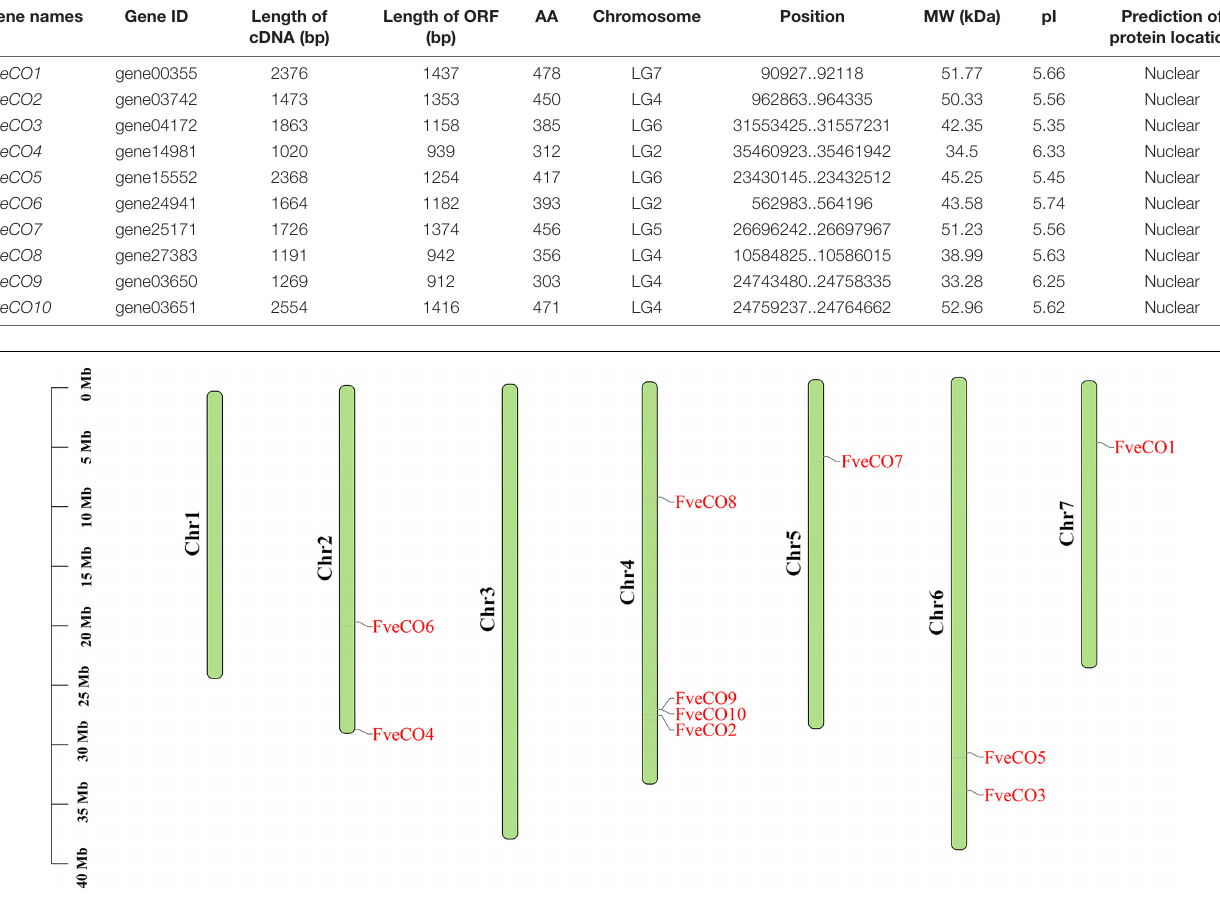
TABLE 1 | Sequence analysis of FveCOs .